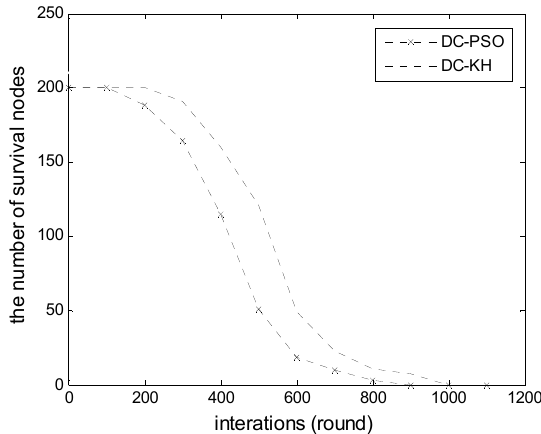
Figure 4. Energy consumption comparison chart of the vice cluster head.